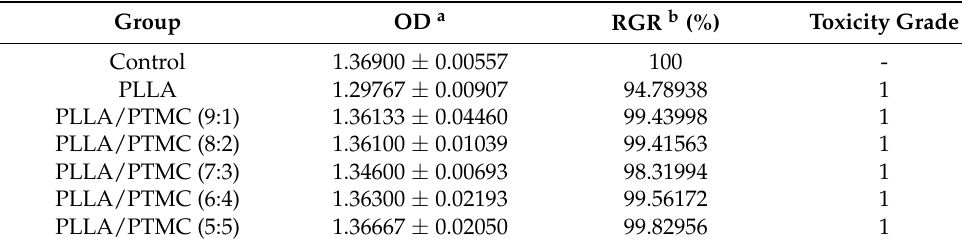
Table 2. Data reflecting the cytotoxicity of PLLA/PTMC blend membranes characterised by different blending ratios incubated for 72 h with MC3T3-E1 cells in vitro.